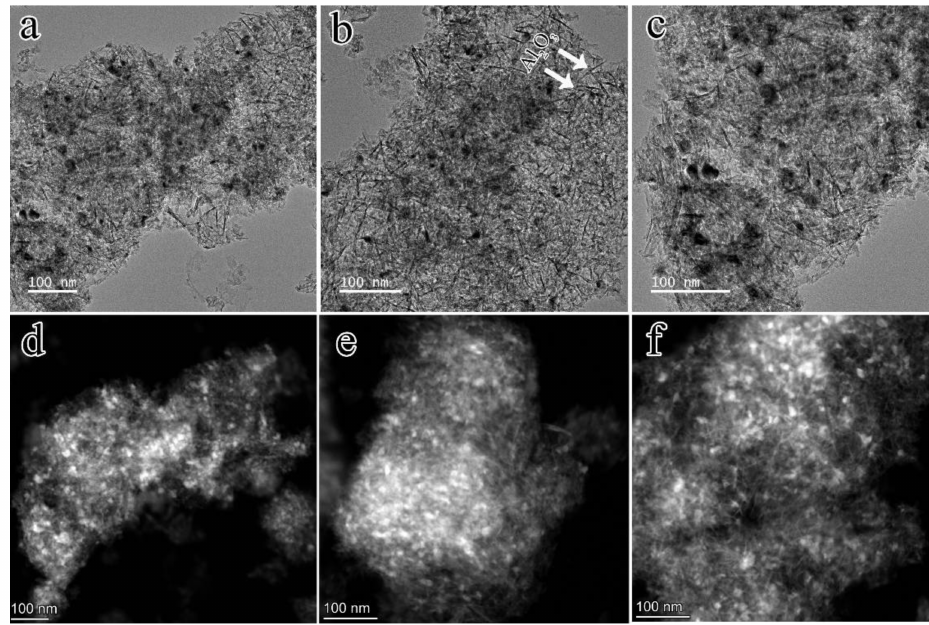
Figure 2. TEM and STEM images of ( a , d ) 10Ni / Al 2 O 3 , ( b , e ) 10Ni4Cu / Al 2 O 3 , and ( c , f ) 10Ni4Zn / Al 2 O 3 after